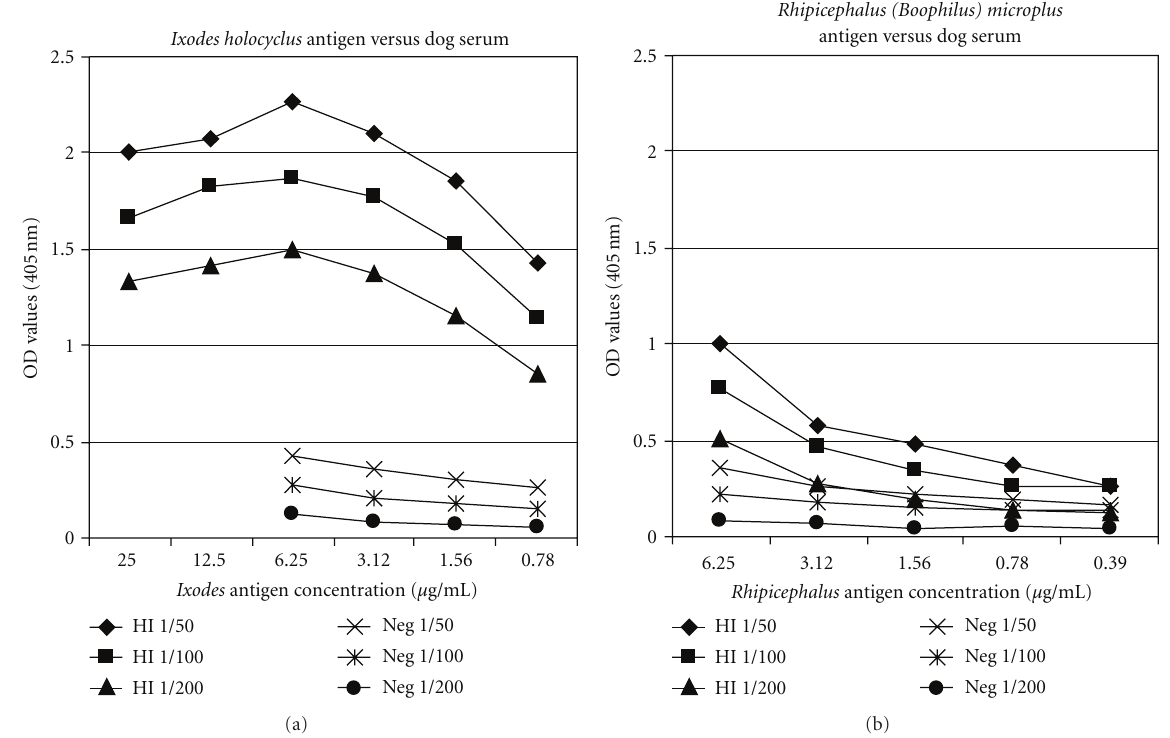
Figure 1: Optimisation of salivary gland antigen concentration in ELISA. Doubling dilutions (1/50–1/200) of pooled hyperimmune (HI) or negative (Neg) dog sera were incubated with varying concentrations of Ixodes (a) or Rhipicephalus (b) antigen in ELISA. Antigens were diluted in carbonate/bicarbonate coating bu ff er and adsorbed to the solid phase at 4 ◦ C overnight. All other steps were performed at 37 ◦ C for 1h as described in Section